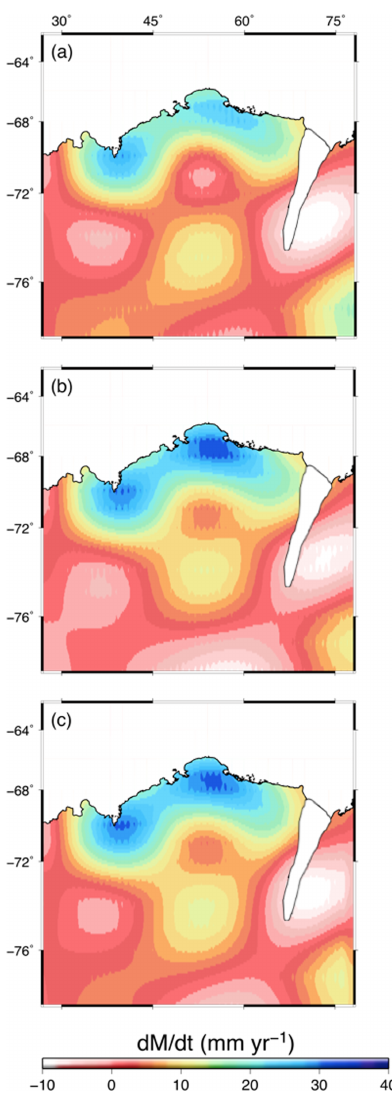
Figure 4. GRACE observations corrected for GIA uplift rates us- ing (a) the ICE-6G_C(VM5) model by Peltier et al. (2015), (b) the W12a model by Whitehouse et al. (2012), and (c) the ICE6G_ANU model by Purcell et al.